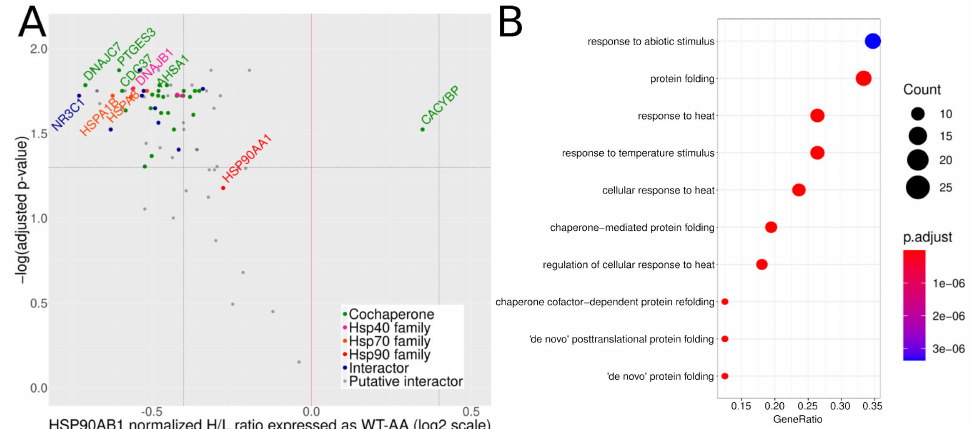
Figure 2. Quantitative exploration of the interactome of WT vs. AA. ( A ) Volcano plot of the inverse log 10 of the adjusted p -value as a function of the normalized H/L ratio in log 2 scale for all 83 quantified interactors (SILAC experiment). Points represent individual proteins. Point color code: co-chaperones in green, Hsp40 proteins in pink, Hsp70 in orange, Hsp90 in red, other already known interactors in blue, and putative interactors in grey. Classification of co-chaperones and known interactors is based on the “Hsp90 interactors” table by Didier Picard (www.picard.ch, accessed on 17 May 2021). Horizontal dashed line marks the 0.05 threshold for the adjusted p -value, vertical dashed lines mark absolute fold-changes greater than 0.4, and vertical red line marks Hsp90 β . ( B ) Gene Ontology (GO) term analysis of the proteins enriched in the AA co-IP. Vertical axis: enriched GO terms. Horizontal axis: the GeneRatio is the ratio between the number of proteins enriched with the corresponding GO term and the total number of proteins identified in the input assigned to the corresponding GO term. Spot size is proportional to the count of proteins enriched (legend on the right of the plot). Spot color corresponds to the adjusted p -value as described in the color scale on the right of the